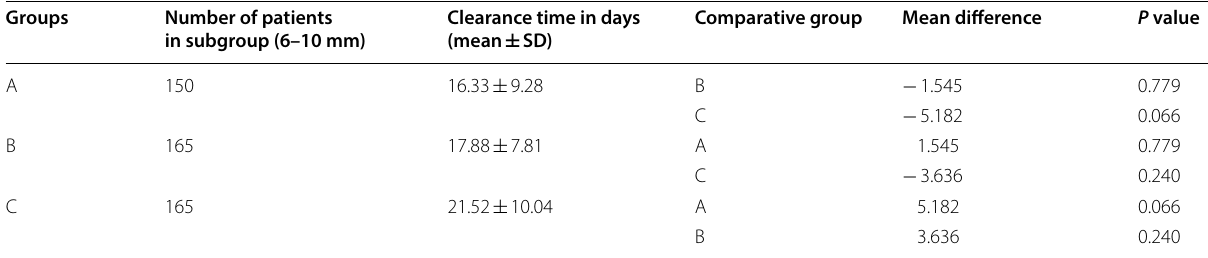
Table 6 Subgroup (6–10 mm) analysis of stone clearance time Groups